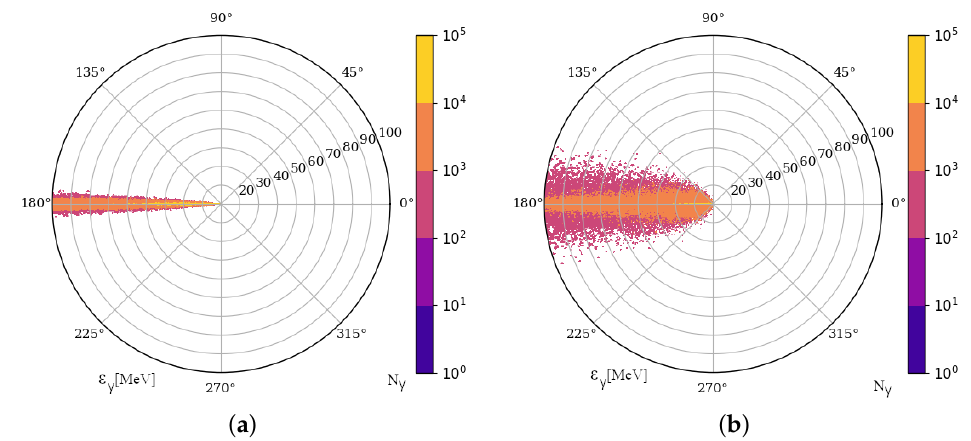
Figure 3. The energy angle distributions of the emitted radiation with the energy up to 100 MeV at 185 fs, integrated in time, for different laser intensities: ( a ) I = 10 22 W/cm 2 ( b ) I = 10 23 W/cm 2 . Laser parameters: λ = 1 µ m, τ = 30 fs FWHM and w 0 = 3 µ m. Electron beam parameters: n e 0 = 10 − 5 n c , = 1.5 GeV. The cutoff energy of the energy angle distribution is: L x = 0.8 µ m, L y = 0.16 µ m and ε e − 0 ( a ) 1150 MeV and ( b ) 1200 MeV.